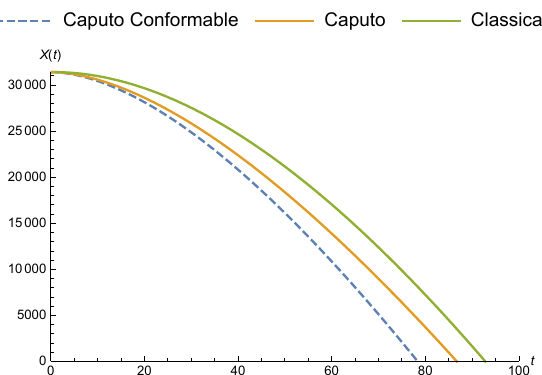
Figure 3. Comparative analysis of the vertical motion of a falling body with different types of derivatives while α = 0.8, β = 1.